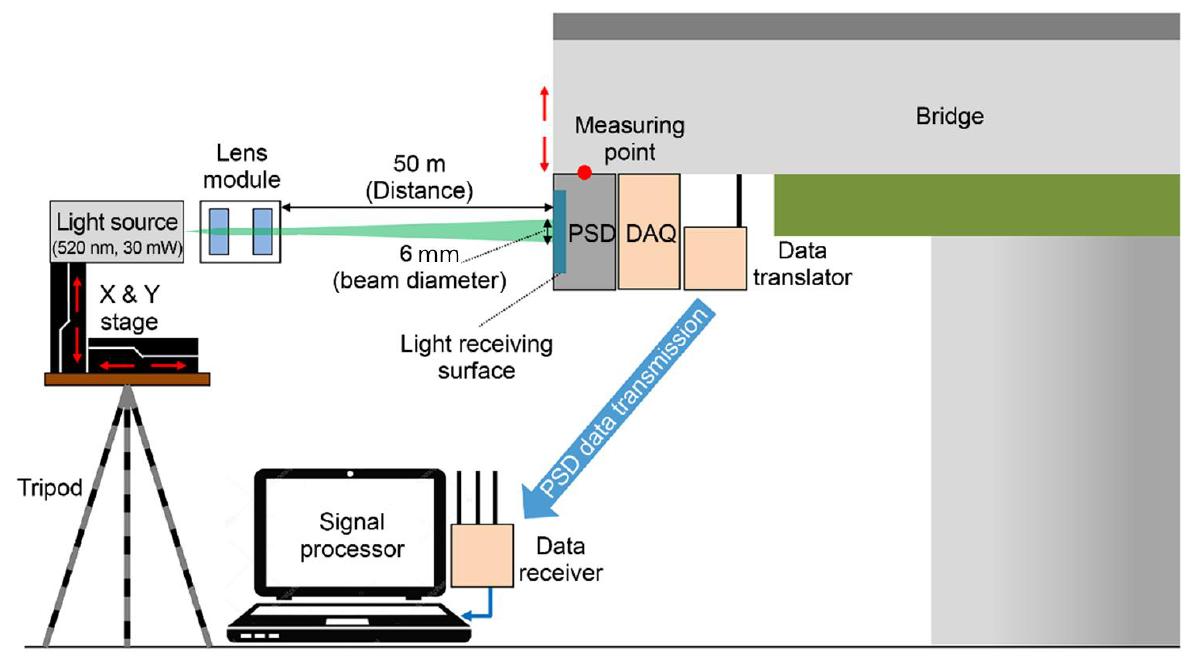
Figure 2. Concept of the sensor application to a bridge.